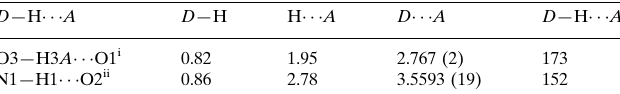
Hydrogen-bond geometry (A˚ , (cid:1)